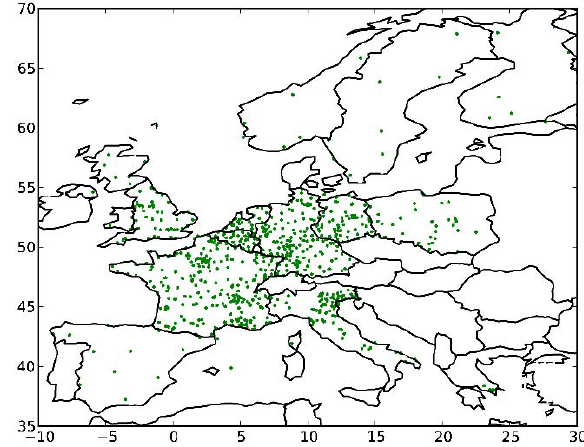
Fig. 1. Example of the location of MACC ozone ground-based stations for the 1 July 2010